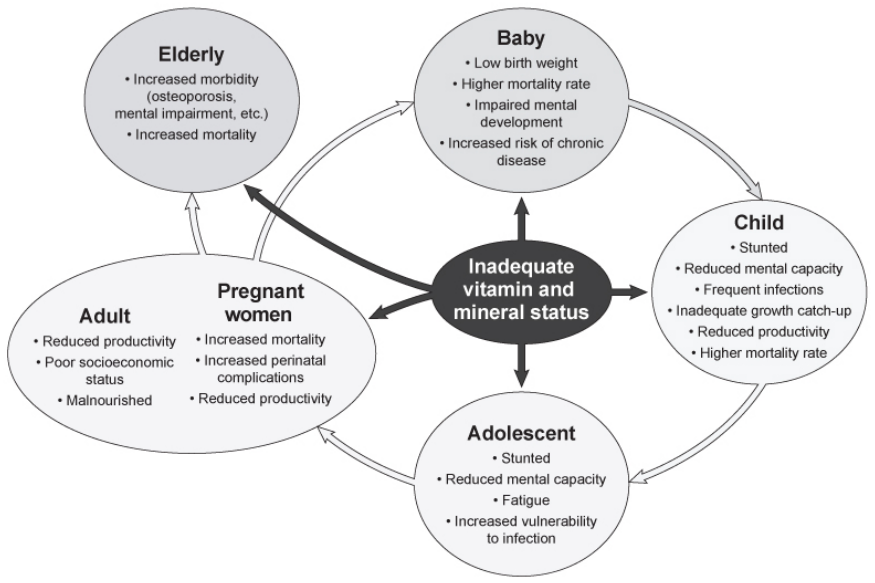
Figure 3. The cycle of micronutrient inadequacies across the life span [7]. Reproduced from Bailey, R.L. et al., with permission from S. Karger AG, Basel.